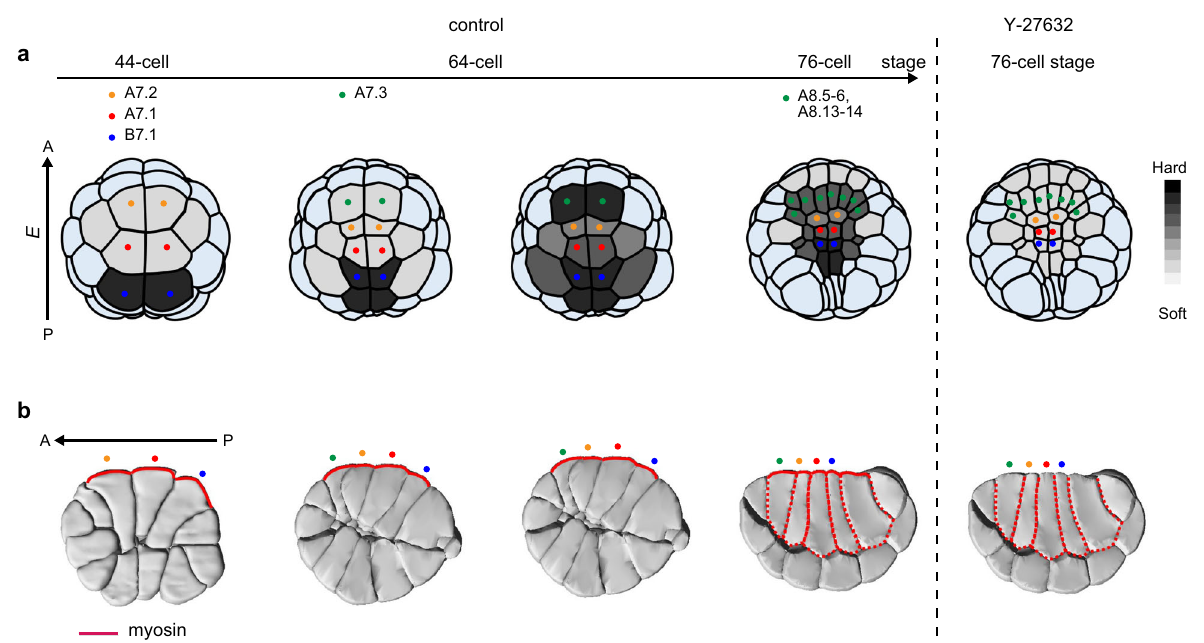
Fig. 7 Schematic of the relationship between actomyosin structures and single-cell stiffening in the ascidian vegetal hemisphere from the 44-cell to 76-cell stage. a Magnitude of E represented by a greyscale (upper). Cell stiffening was reduced completely by Y-27632 treatment. b Myosin began to accumulate in apical regions from the 44-cell stage and was then recruited to both circum – apical and basolateral regions from the 64-cell to 76-cell stage, as reported in Ref4.. Solid curves (red) represent myosin accumulated in apical regions, while the dotted curves (red) represent myosin accumulating in the basolateral region. Dotted colours represent those in a . After treatment with Y-27632, myosin in apical regions was disrupted, but not in the basolateral